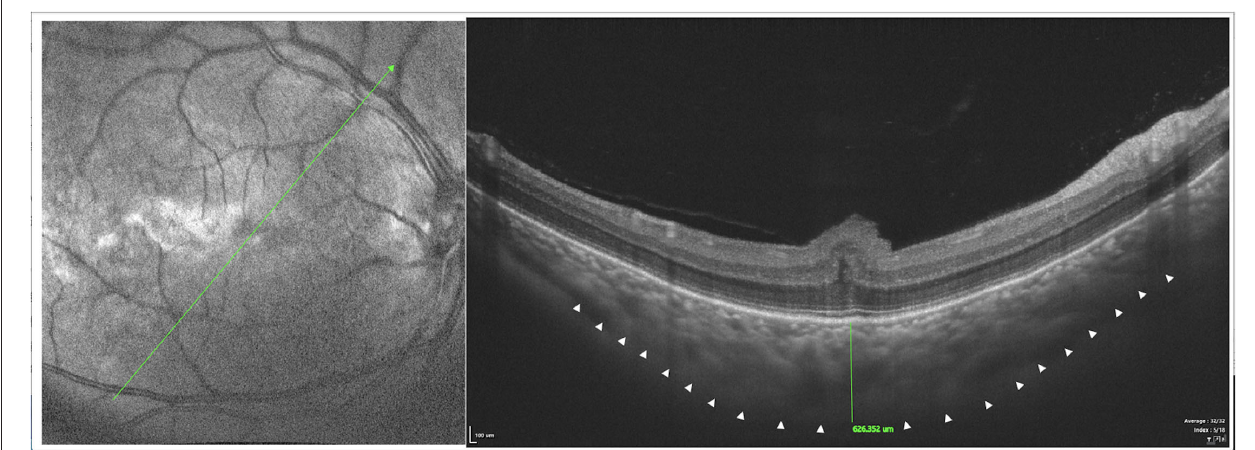
FIGURE 8 | SS-OCT (SS-OCT, VG200D, SVision Imaging, Ltd., China) in type 1 showed that each retinal layer was uneven and wavy with pachychoroid, leopard-sign spots in the fundus corresponding to accumulation of outer retinal material, which presented as focal thickening of the RPE layer.